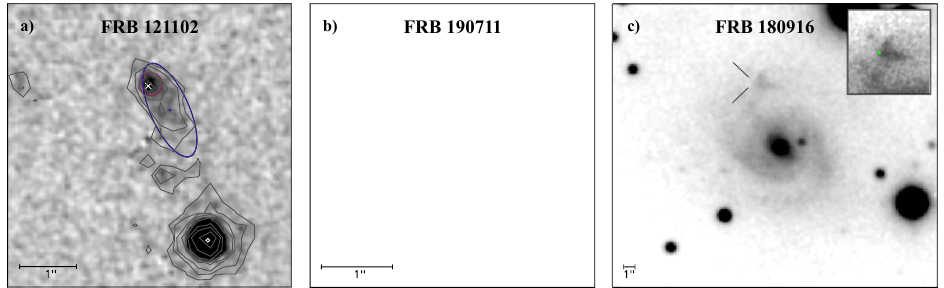
Figure 1. The three repeaters with an identified host galaxy. ( a ) HST -IR image of the FRB 20121102A host galaxy (adapted with permission from Bassa, C., et al.; published by IOP Publishing, 2017 [76]). The white cross mark the FRB 20121102A position. The red circle and the blue ellipse denote the half-light radius of the bright knot and of the extended diffuse emission, respectively. The contours indicate the extent of the host galaxy. ( b ) HST -IR image of the FRB 20190711A host galaxy (adapted with permission from Mannings, A. G., et al.; arXiv preprint, 2020 [39]).The ellipse marks the FRB position (2 σ uncertainty in each coordinate). ( c ) Gemini-North FRB 20180916B host galaxy image ( r (cid:48) filter) taken from the Public Gemini Observatory Archive (https://archive.gemini.edu, Program ID GN-2019A-DD-110; see [46]). The star-forming region containing the FRB 20180916B position (small green circle) is zoomed-in in the inset. In all images North is up and East to the